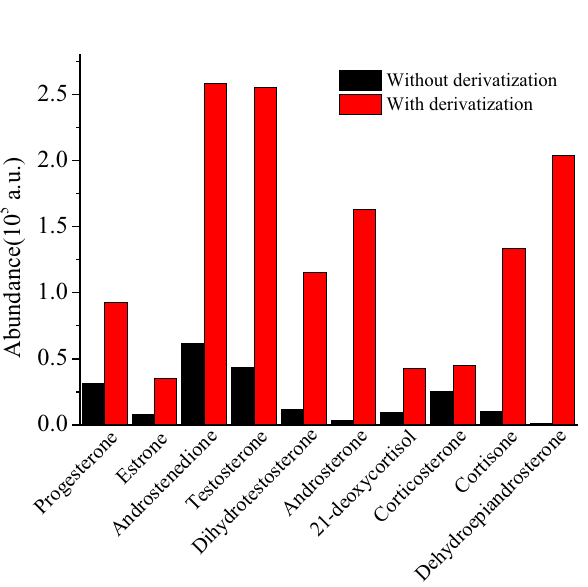
Fig. 5 Comparison the ion intensity for the analysis with derivatiza- tion and without derivatization at the concentration of 50 ng mL